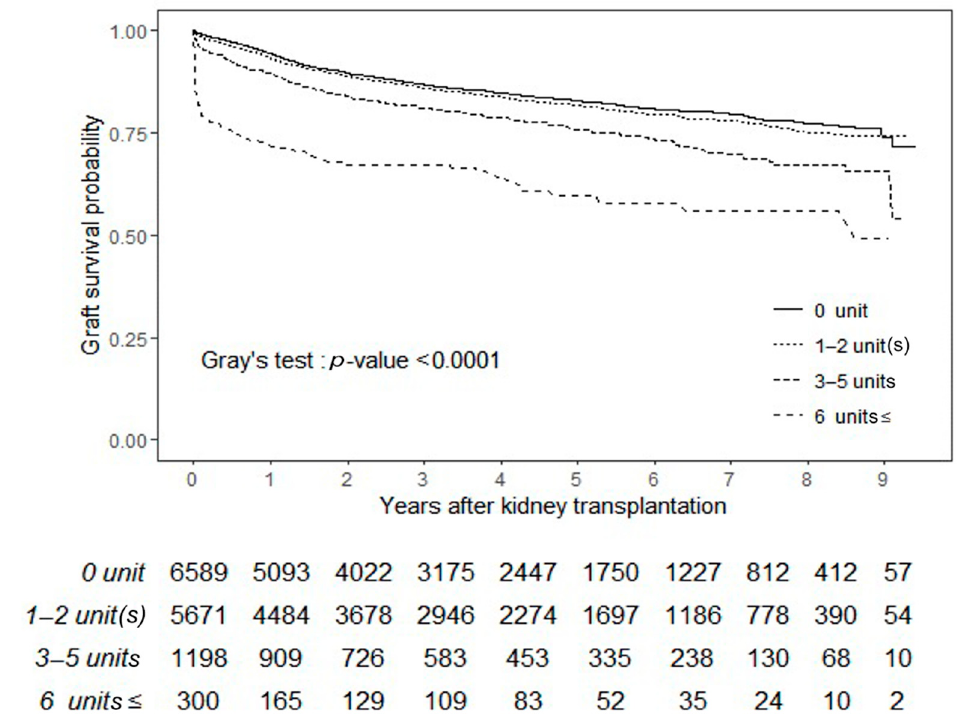
Figure 1. Death censored graft survival rate according to the amount of perioperative RBC transfusion. Graft survival rates were higher in patients who received less RBC transfusion (Fine and Gray model, p < 0.001). Abbreviations: KT, kidney transplantation and RBC, red blood cell.